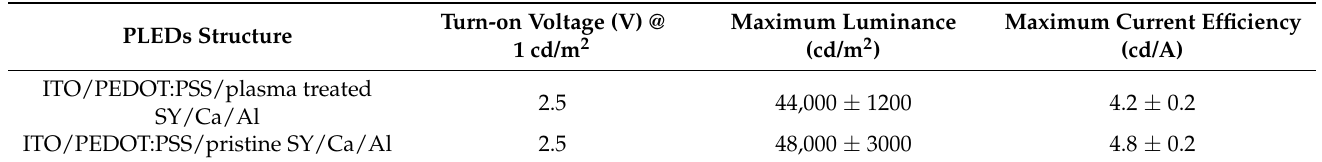
Table 4. Turn-on voltage, maximum luminance and maximum current efficiency of two PLEDs, one with plasma-treated SY layer and second with non-treated SY